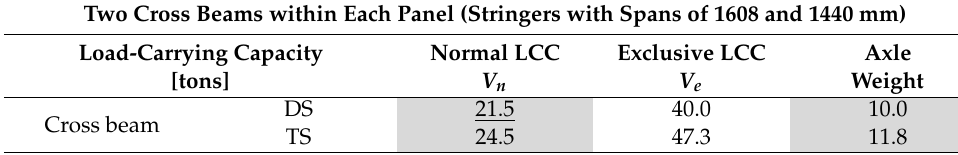
Table 8. Cross beam load-carrying capacity when two cross beams are used per